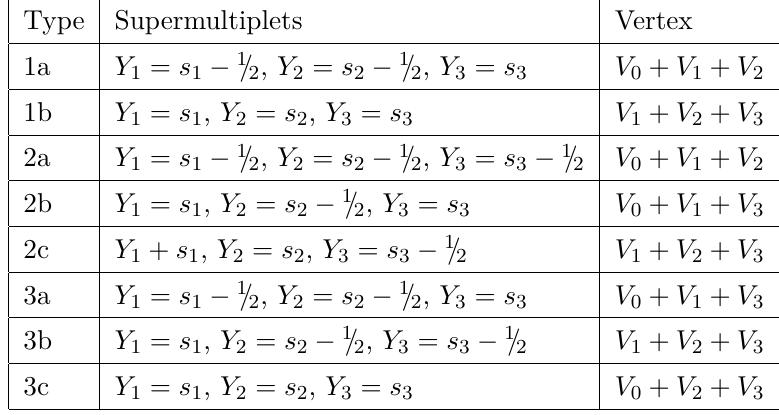
Table 1 . Different types of the massless flat supersymmetric cubic